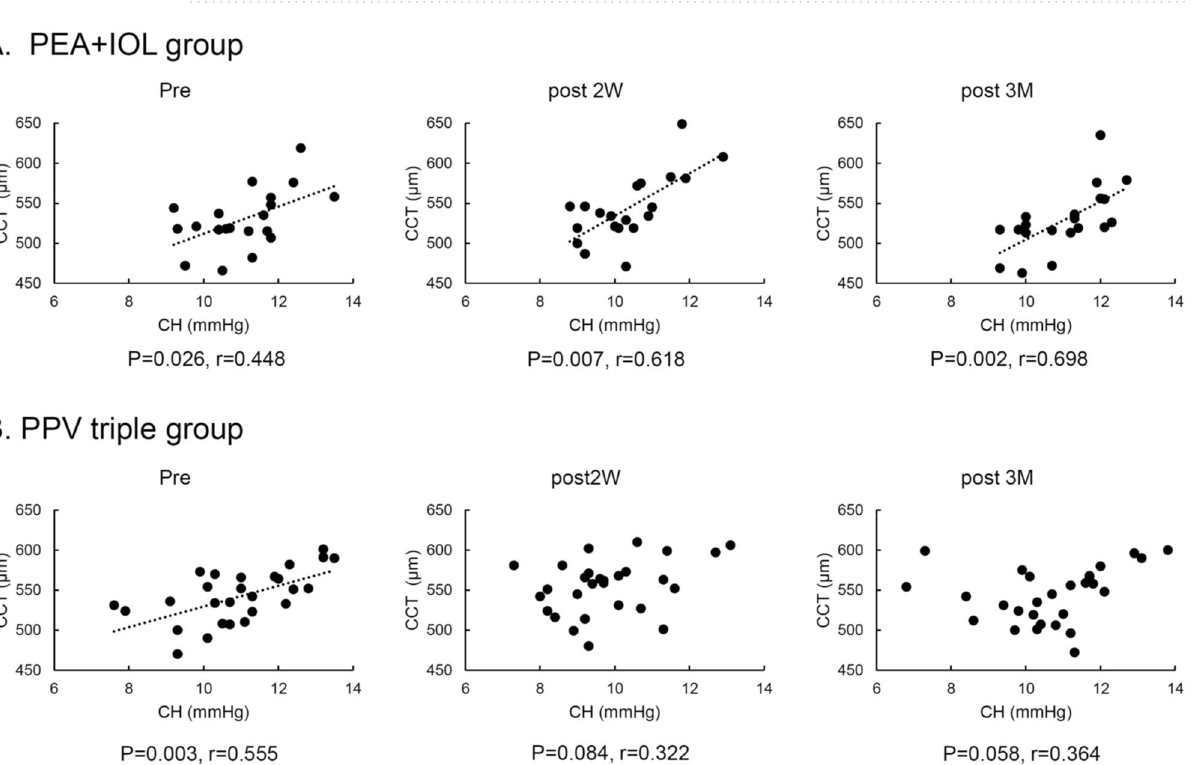
Figure 4. In PEA + IOL group ( A ), positive correlation between CH and CCT at all-time points; r = 0.448, p = 0.026 preoperatively, r = 0.618, p = 0.007 at 2 weeks postoperatively, r = 0.698, p = 0.002 at 3 months postoperatively. In the PPV triple group ( B ), positive correlation between CH and CCT preoperatively (r = 0.555, p = 0.003), but there was no correlation after surgery; r = 0.322, p = 0.084 at 2 weeks postoperatively, r = 0.364, p = 0.058 at 3 months